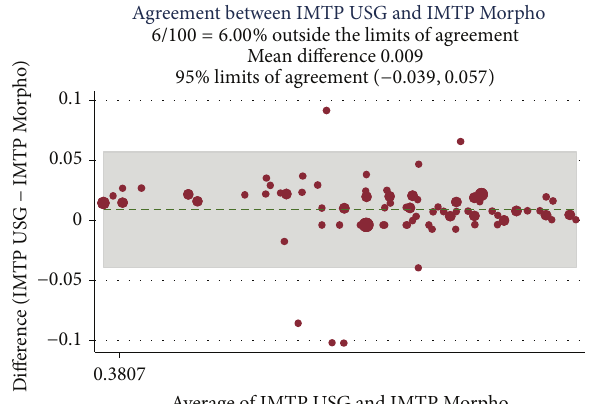
Figure 5: ICC was 0.89 with mean difference of − 0.009; limit of agreement was 95% with upper and lower limits of − 0.039 and 0.057. 6% values are above the limit of agreement, which means both of these methods are in agreement.